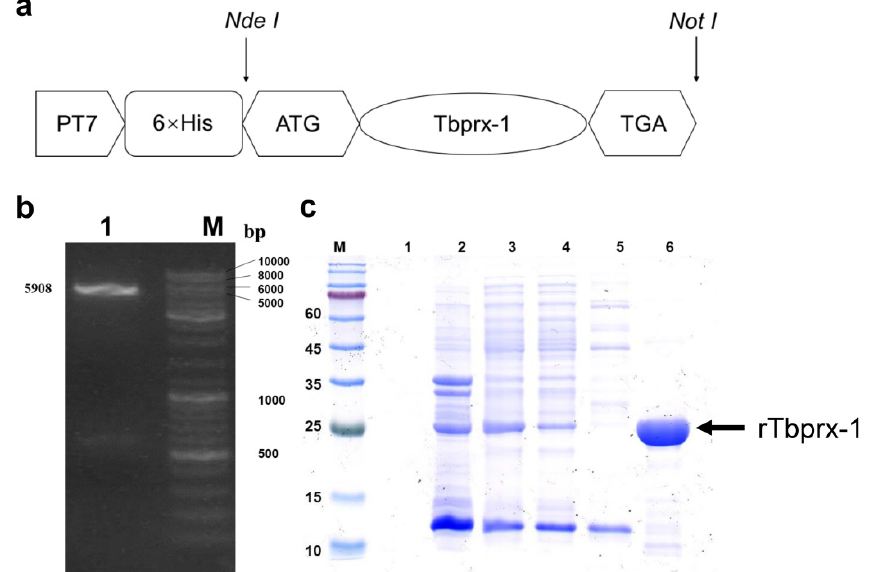
Figure 3. Construction of the recombinant expression vector. ( a ) Structural map of the pET-28a(+)- Tbprx-1 recombinant plasmid vector. ( b ) pET-28a(+) plasmid map after double enzymatic digestion.